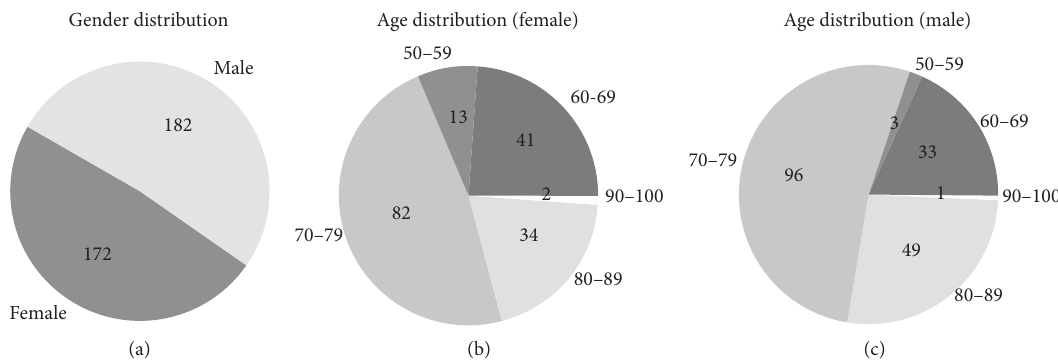
Figure 5: Distribution of patient ages and genders. (a) Gender distribution. (b) Female age distribution. (c) Male age